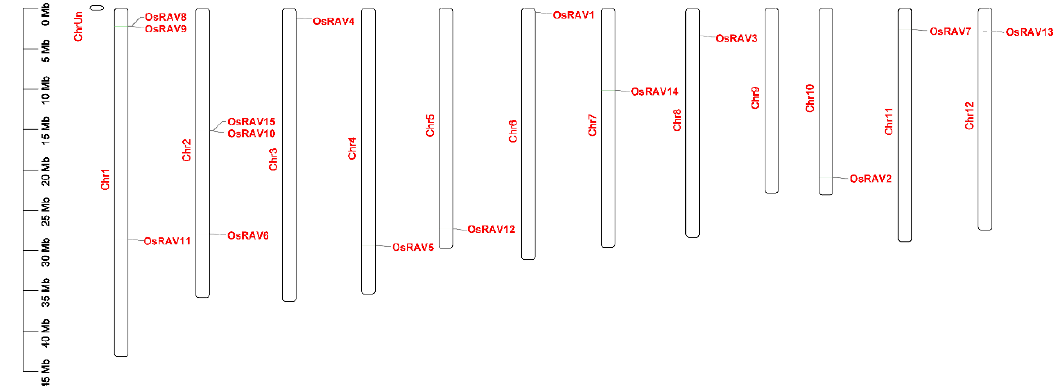
Figure 4. Distribution of RAV genes on the 12 chromosomes of Os ( Oryza sativa ). The RAV genes are shown on the right side of each chromosome. The gene location and the size of each chromosome can be estimated using the scale on the left side of the figure.